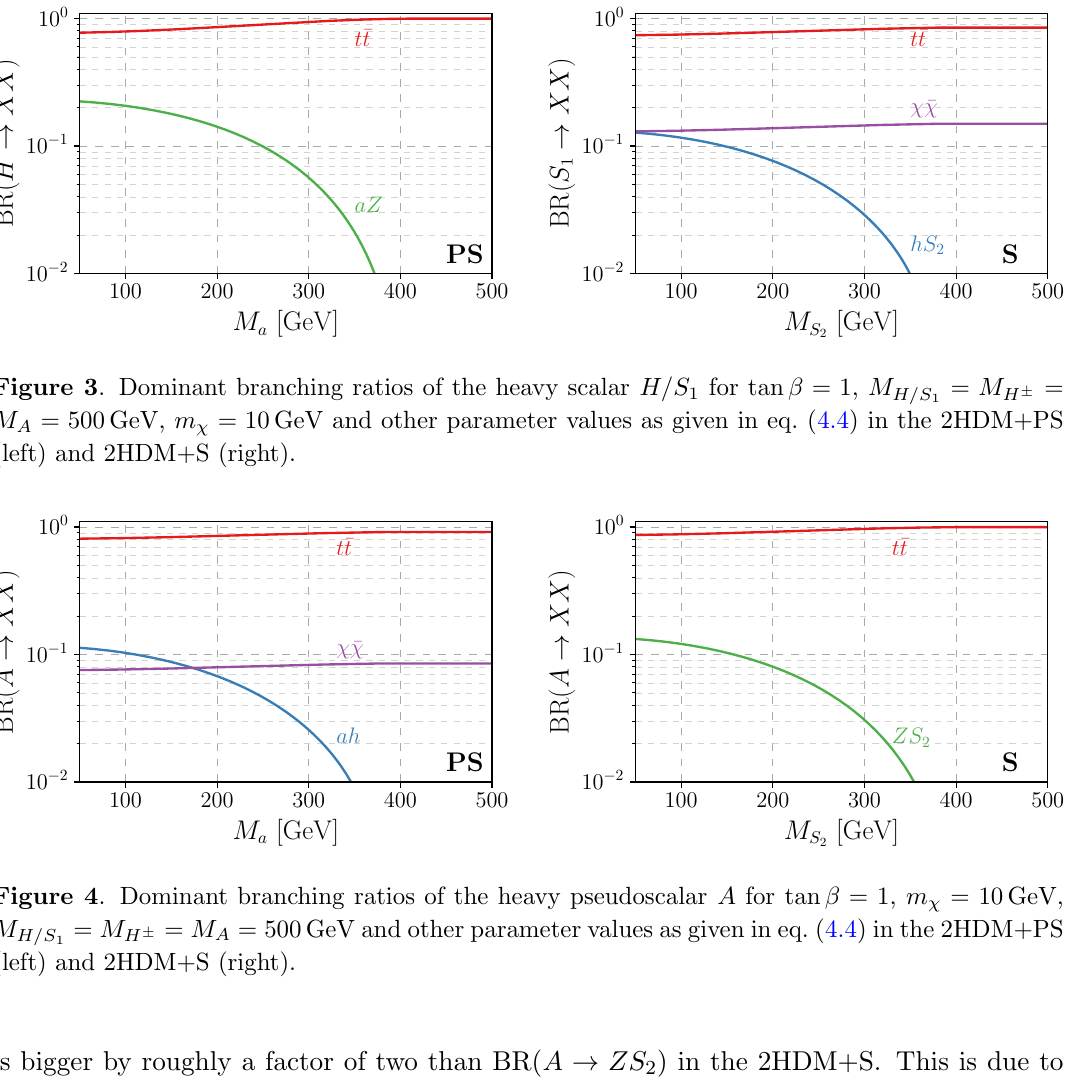
Figure 4 . Dominant branching ratios of the heavy pseudoscalar A for tan (cid:12) = 1, m (cid:31) = 10 GeV, M = M = M A = 500 GeV and other parameter values as given in eq. (4.4) in the 2HDM+PS H=S 1 H (cid:6) (left) and 2HDM+S